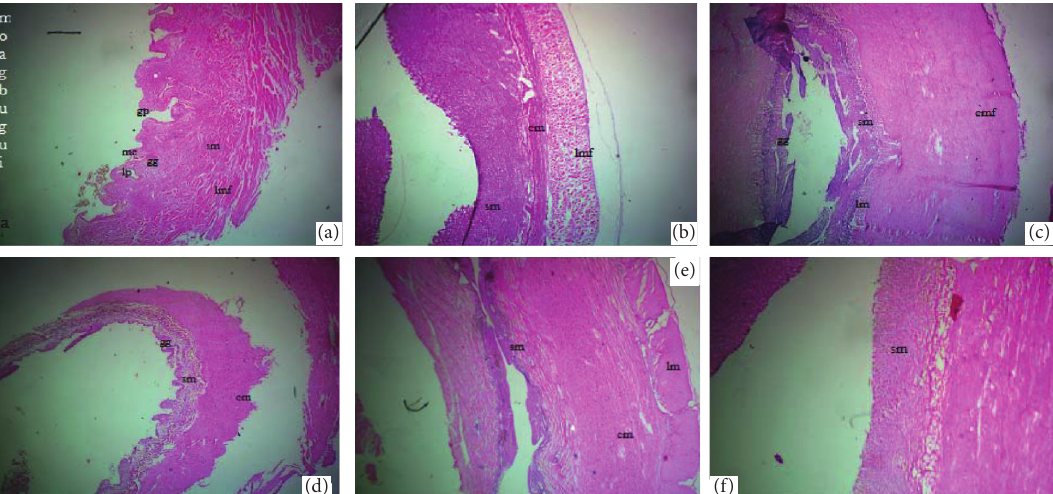
Figure 8: Histology of the gastrointestinal tract of H. niloticus : (a) oesophagus; (b) stomach; (c) pyloric ceca; (d) small intestine; (e) large intestine; (f) cloaca. gg, gastric gland; sm, submucosa; gp, gastric pits; lp, lamina propria; mc, mucus cells; cmf, circular muscle fibre; lmf, longitudinal muscle